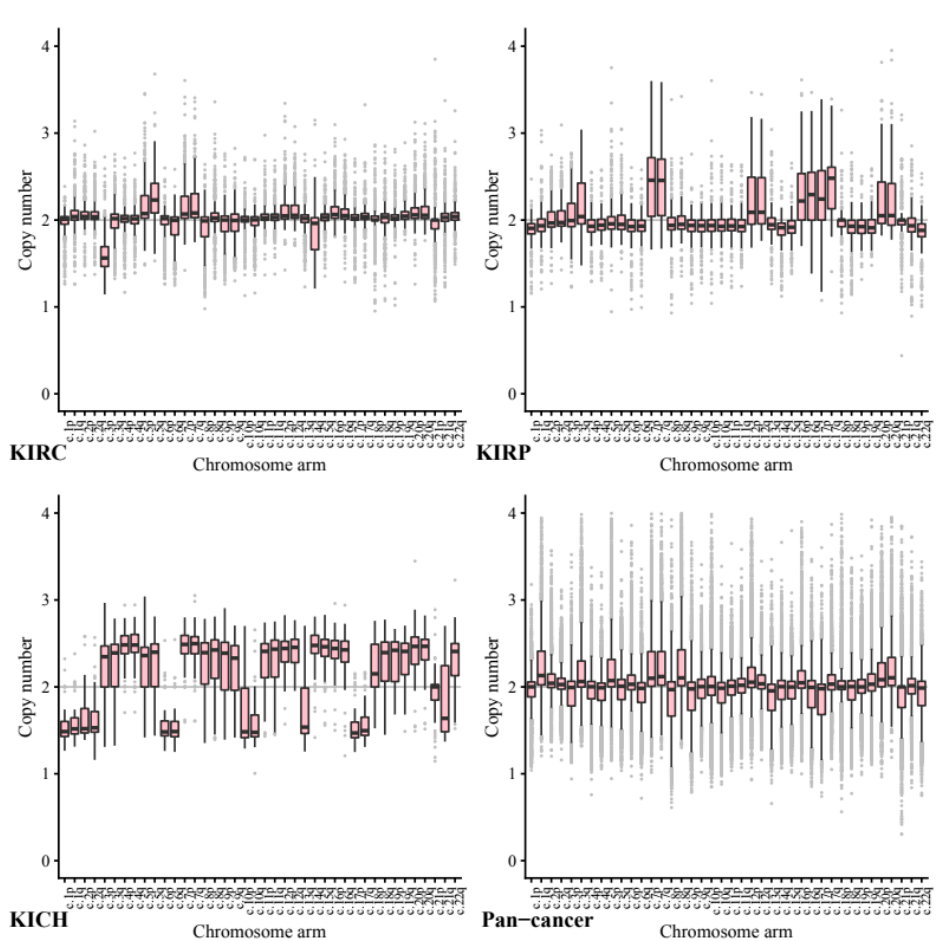
Figure 2. Chromosome Arm-wise copy number. By grouping chromosome arm-wise copy